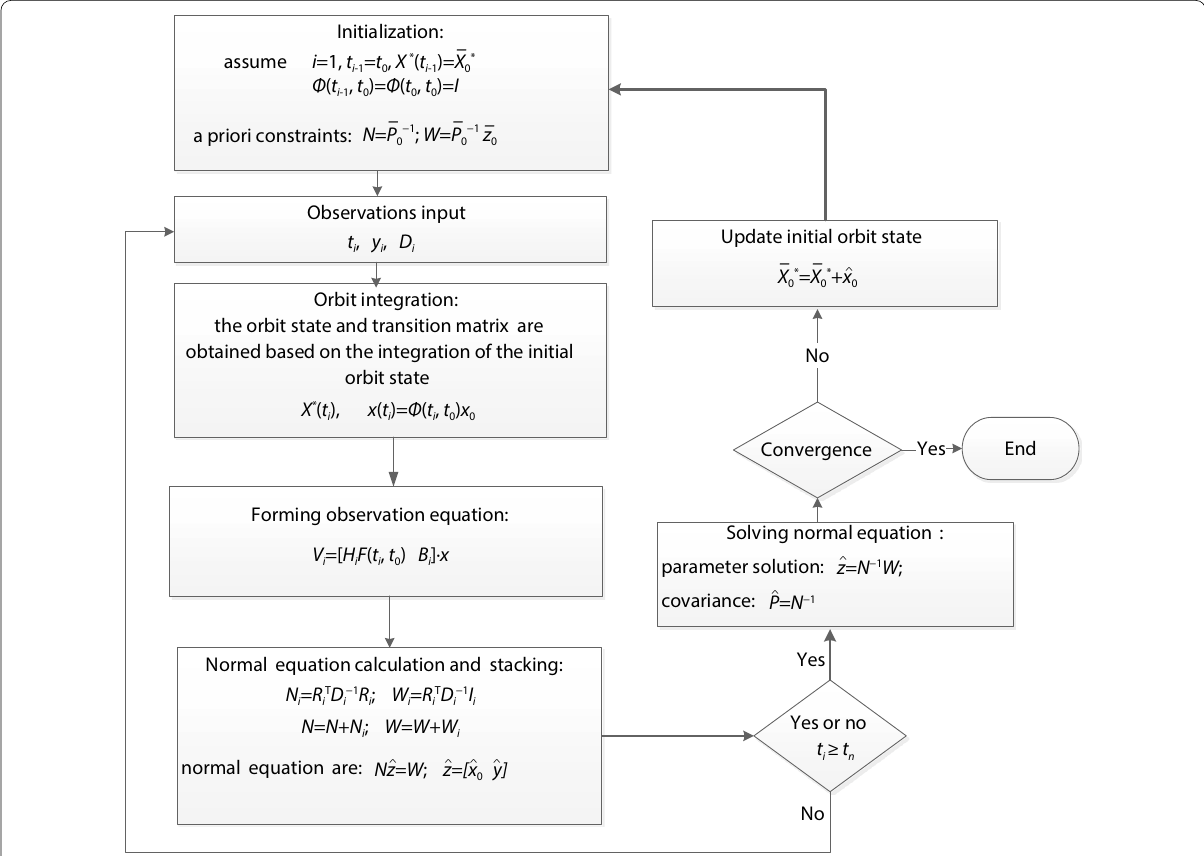
Fig. 1 Data processing flow of the batch calculation